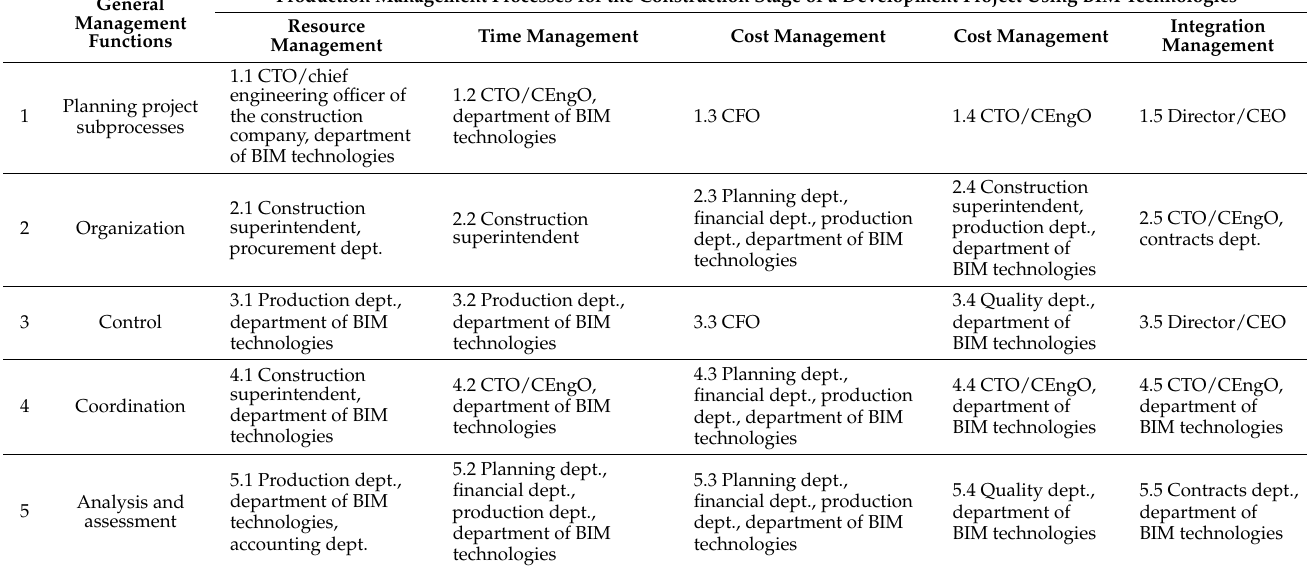
Table 3. Management processes and stakeholders in the course of implementing development projects.